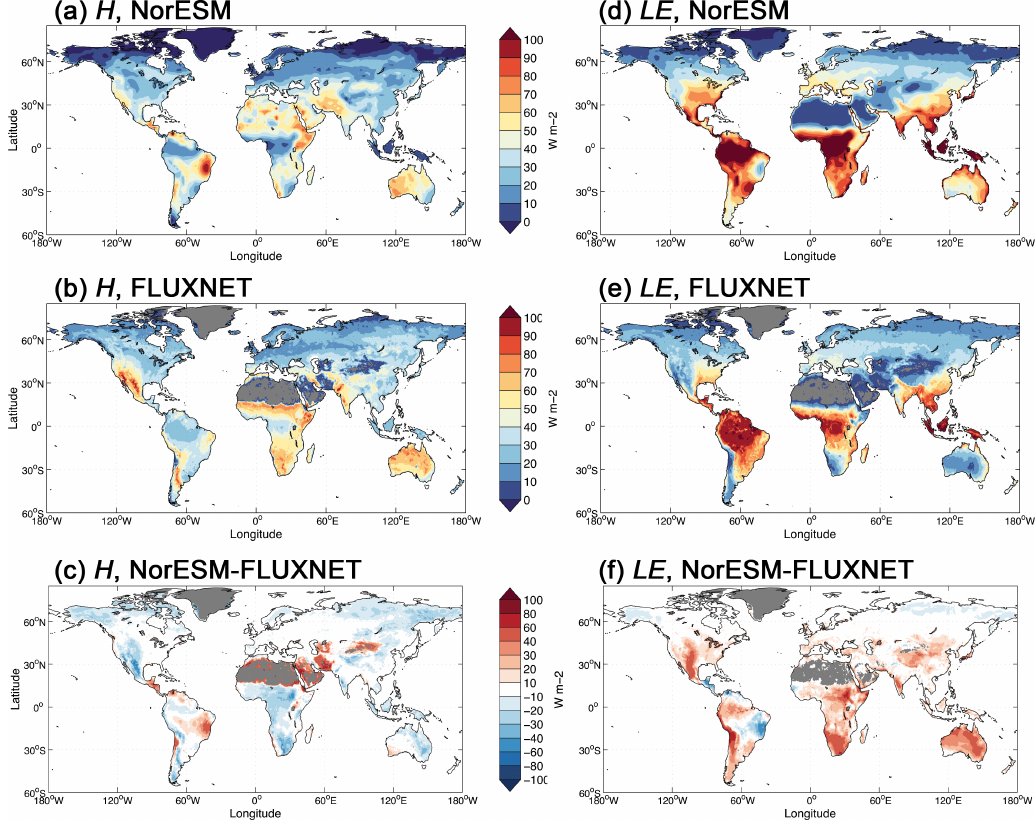
Fig. 5. The left panels show sensible heat flux from (a) NorESM, (b) FLUXNET-MTE estimates, and (c) the difference of (a) − (b) . The right panels show latent heat flux from (d) NorESM, (e) FLUXNET-MTE estimates, and (f) the difference of (d) − (e) . The NorESM fluxes are means for the years 1976–2005 of the Historical1 experiment, and the FLUXNET-MTE fluxes are means for the years 1982–2005. Areas with missing observations are shaded with dark grey colour.